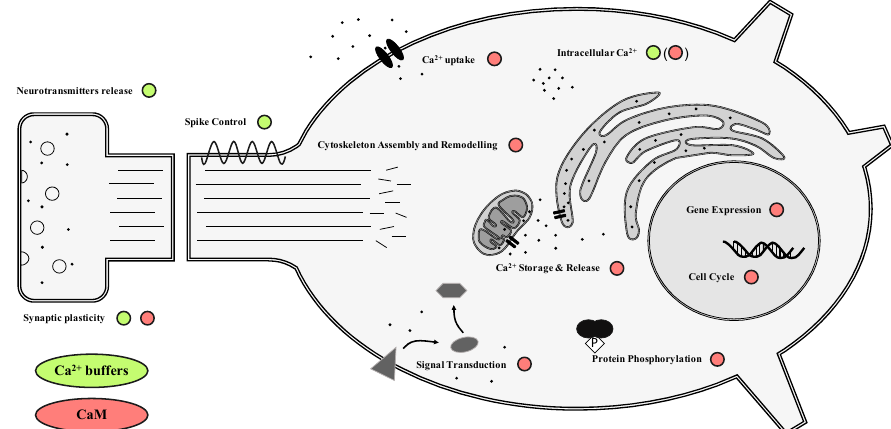
Figure 1. Schematic overview of the functions of buffer and sensor calcium-binding proteins (CBPs) in neurons. Ca 2+ buffers directly control intracellular Ca 2+ concentration during Ca 2+ transients. As a